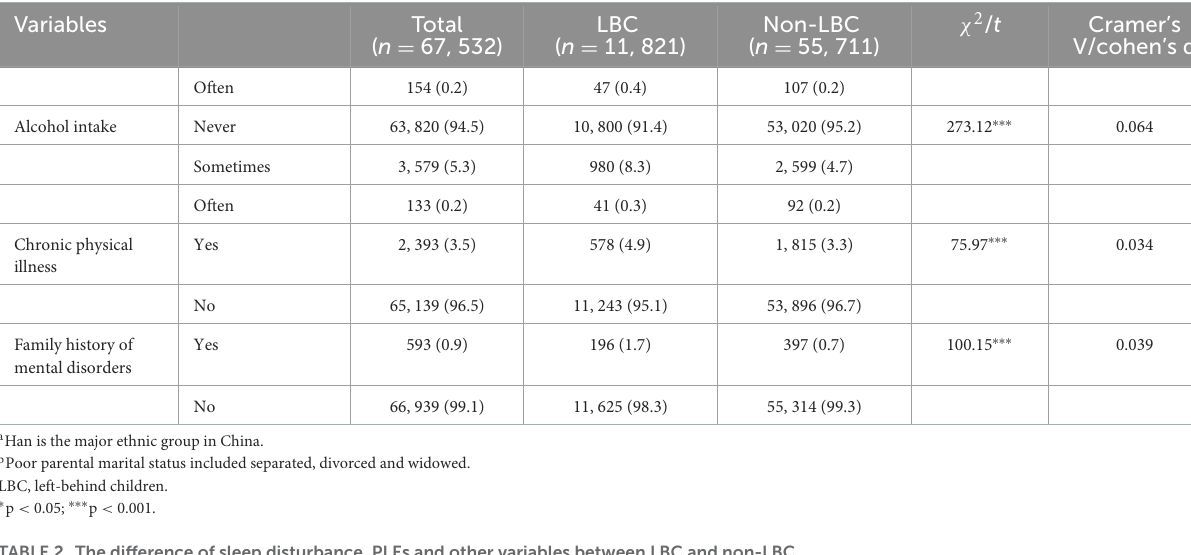
TABLE 2 The difference of sleep disturbance, PLEs and other variables between LBC and